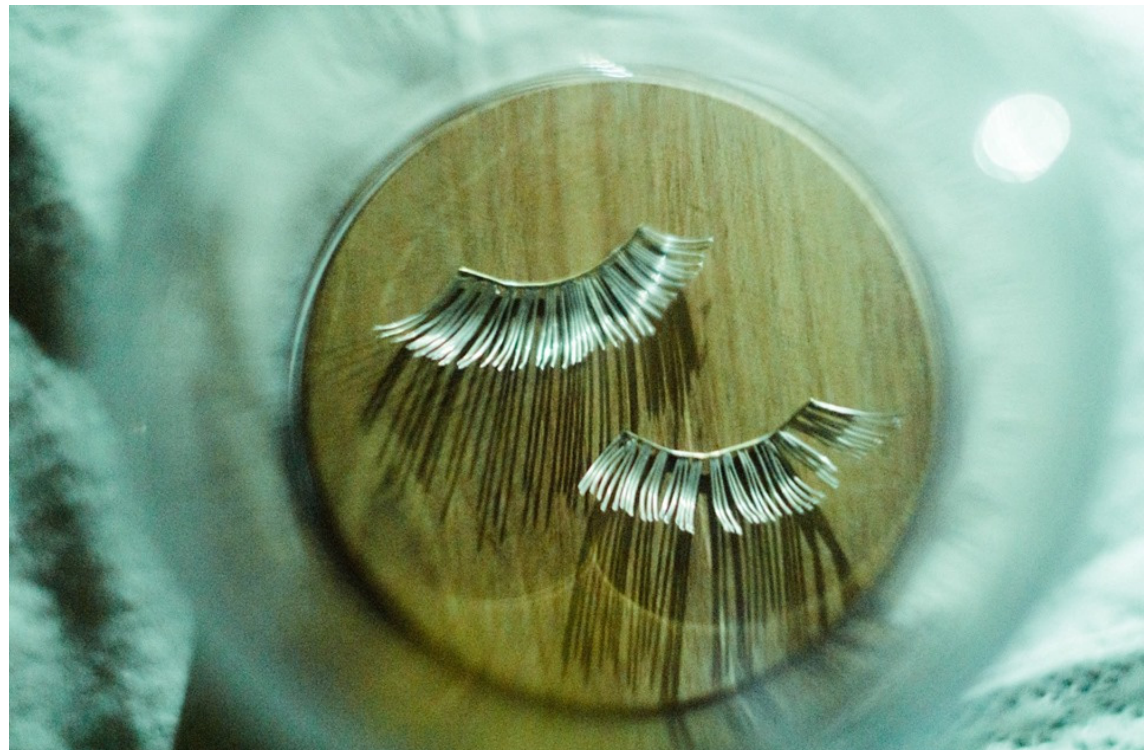
Figure 2. Place of Pleasures . Insomniac eyelashes made of silver by Alda Salavisa. Mãe d’Água das Amoreiras Reservoir, Lisbon, 2019. © Joana Linda.